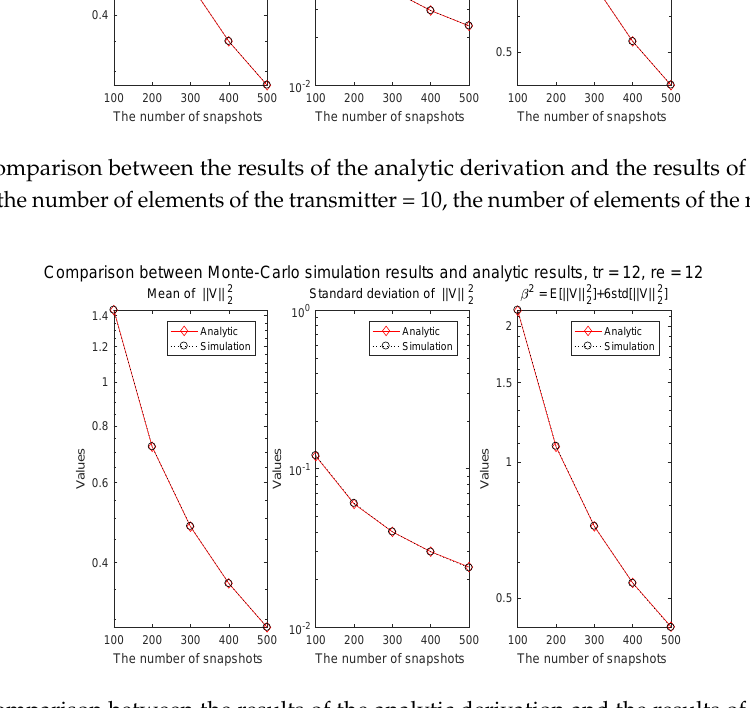
Figure 5. Comparison between the results of the analytic derivation and the results of Monte Carlo simulation (the number of elements of the transmitter = 12, the number of elements of the receiver =